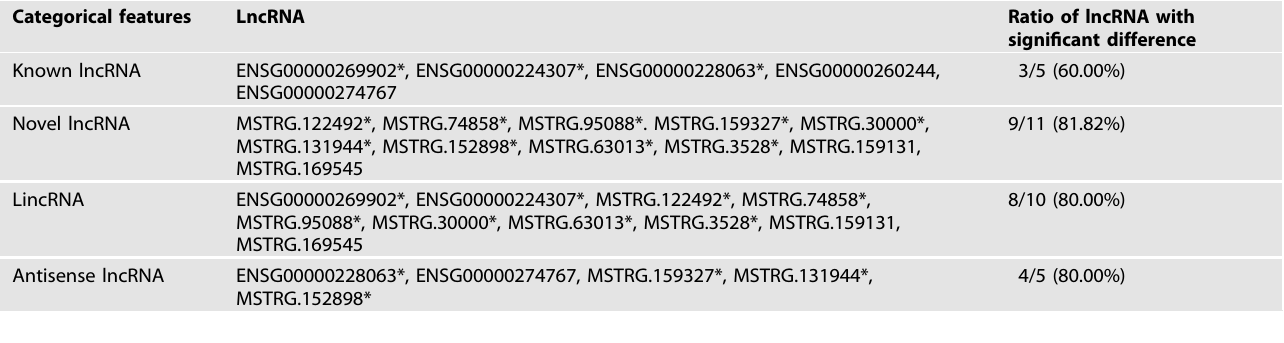
Table 5. The information of 12 lncRNAs positively validated in the expanding cohort in present study and their potential orthologous sequences comparing with mouse data. LncRNA Novel/known The log2 value in the RNA-seq data Orthologous sequence with mouse known